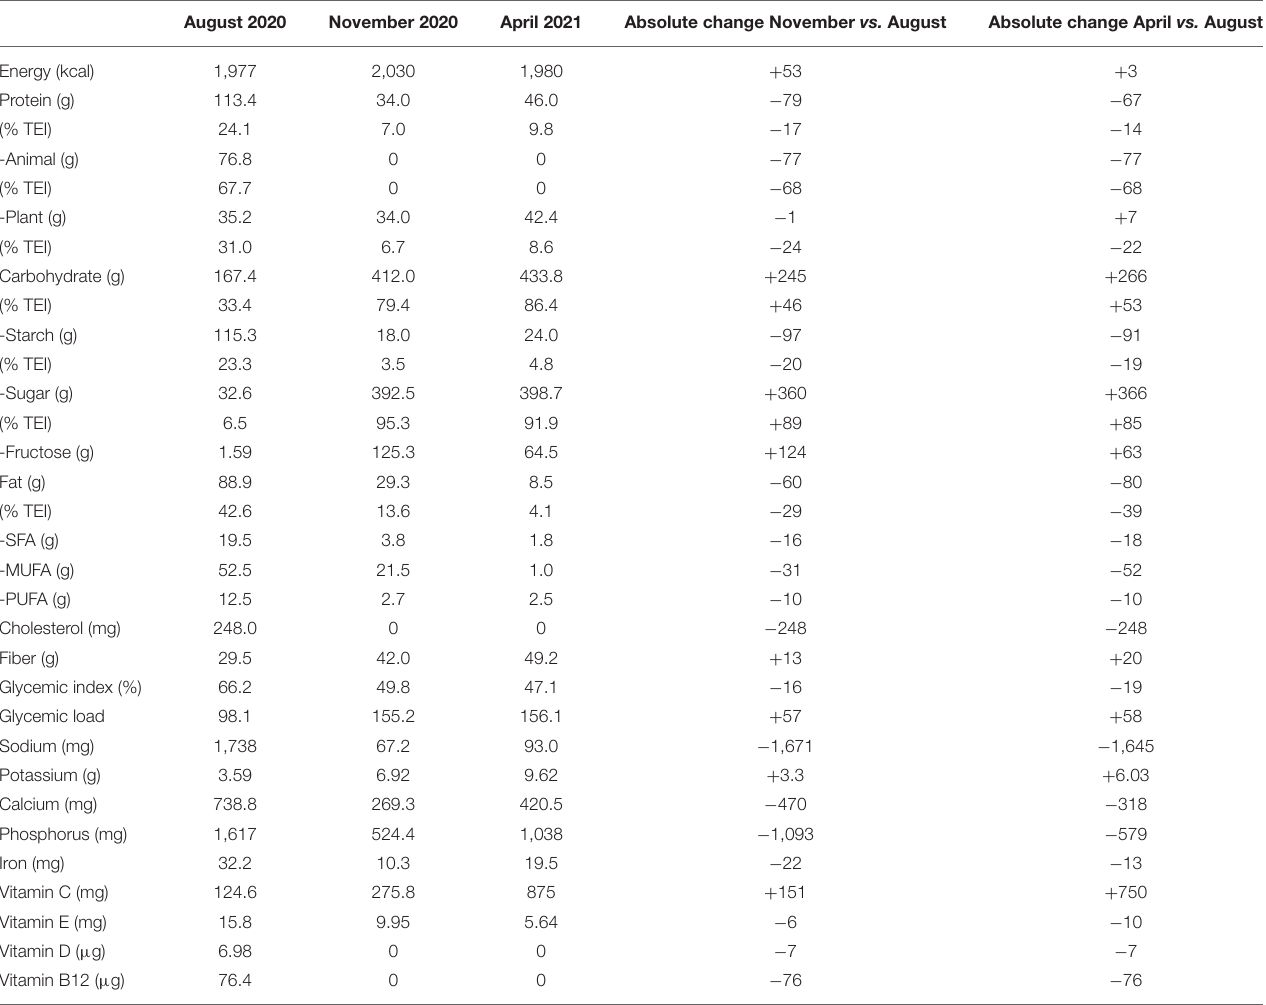
TABLE 2 | Mean daily energy intake and dietary composition obtained through 7-day food records during